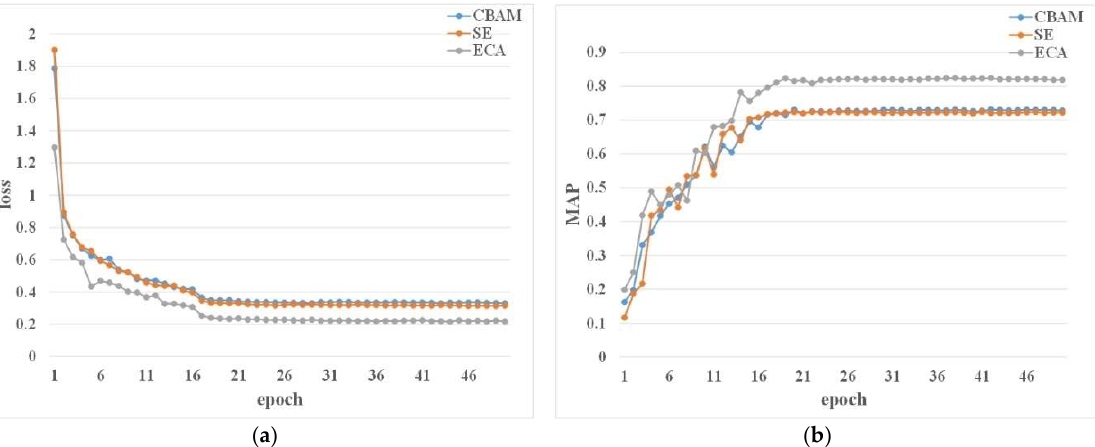
Figure 11. Loss and mAP of the models with different AM modules. ( a ) Loss of the models with different AM modules. ( b ) mAP of the models with different AM modules.